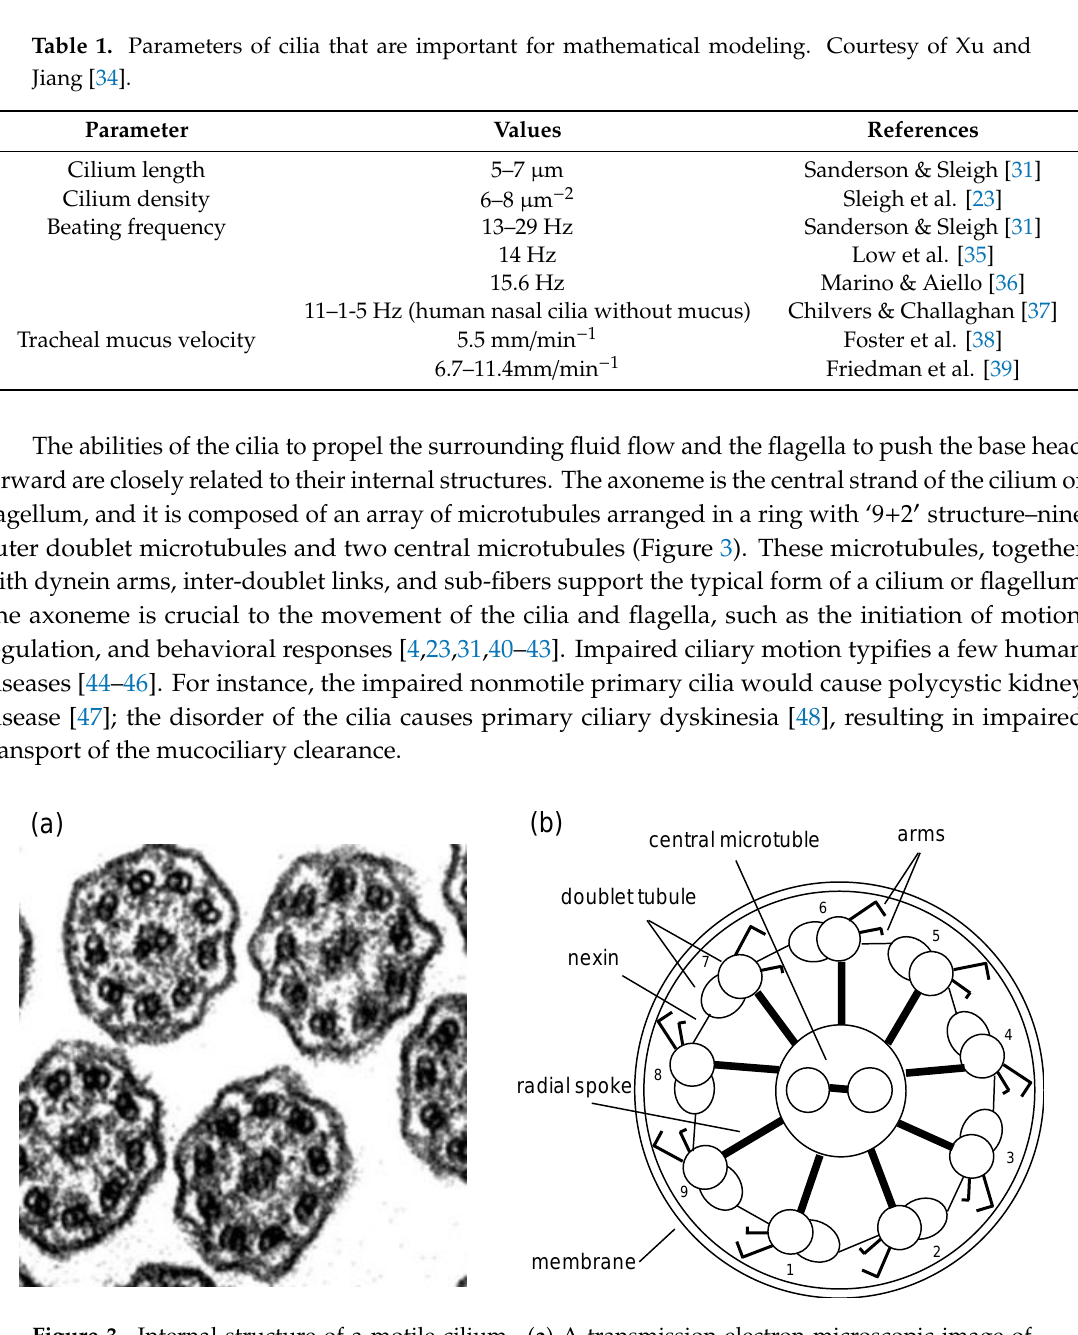
Figure 3. Internal structure of a motile cilium. ( a ) A transmission electron microscopic image of an axoneme, with permission from Dirksen & Satir [49]. ( b ) A schematic drawing of the “9+2” axoneme illustrating 9 microtubule doublets connected to the central two microtubules through radial spokes. Also shown are the nexin links connecting the doublets and the dynein motor arms expending from doublets.